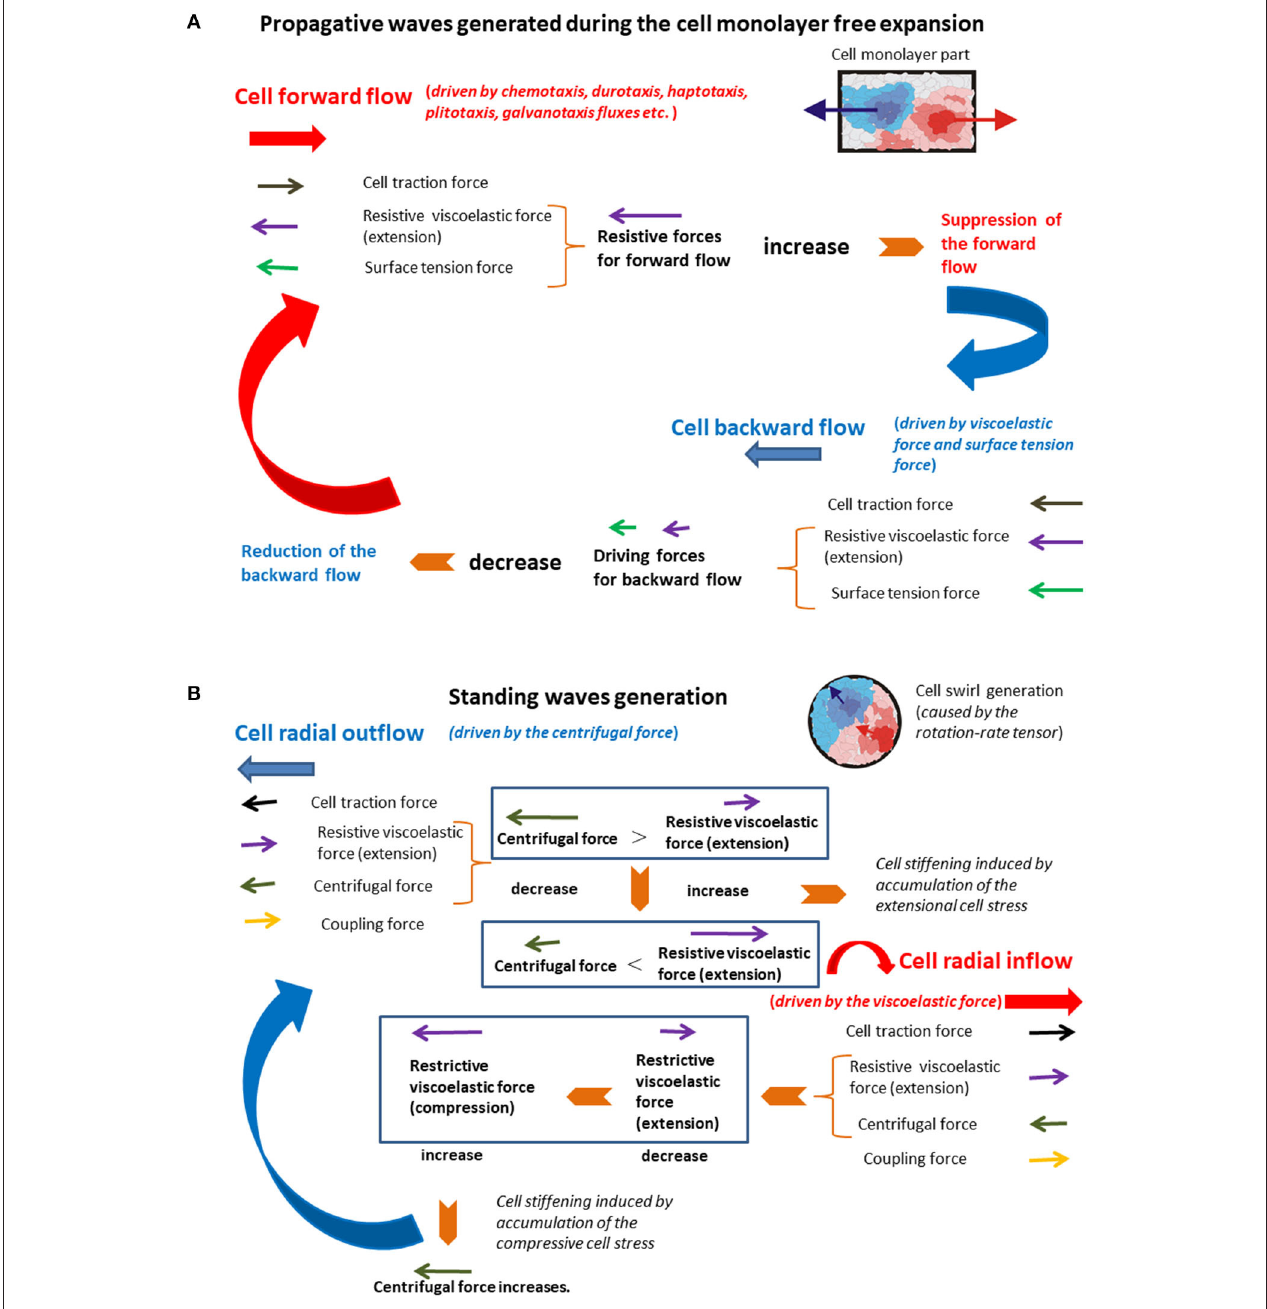
FIGURE 4 | (A,B) The schematic presentation of the force balance for the generation of (A) propagative waves and (B) standing waves.